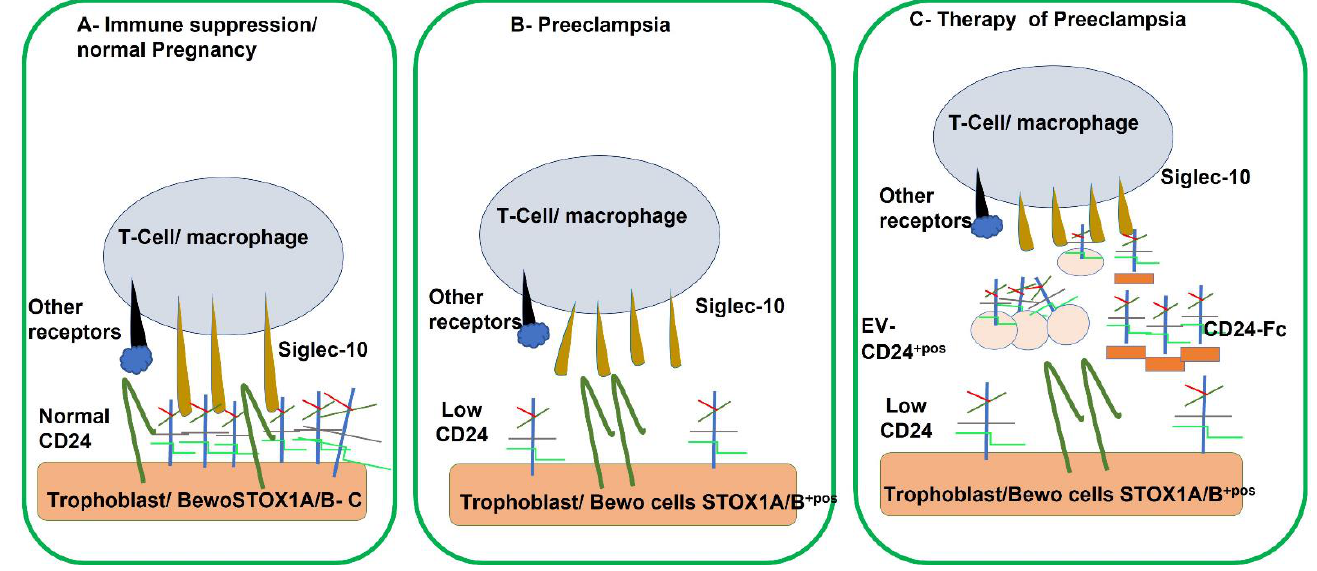
Figure 3. A schematic model of the potential role of CD24 in a normal and in preeclampsia is depicted to indicate how CD24 replenishment could help fighting preeclampsia. ( A ) In normal pregnancy, the immunosuppressive process involves the formation of a complex made of CD24, Siglec-10 and the control STOX1 A/B (STOX1-A/B — C) on the surface of BeWo/trophoblast cells. The complex triggers the inhibitory signals and promotes immunosuppression. ( B ) in preeclampsia there is a reduced amount of CD24-Siglec 10 due to the over expression of the mutated variants of sTOX1 A/B on the surface of the BeWo cells, leading to the loss of immune suppression. ( C ) When replenishment the cultured cells with extracellular vesicles (EV) that have a rich expression of CD24 on their surface, (EV-CD24 +pos ) or with CD24-Fc soluble molecule, the BeWo/trophoblast regain immune tolerance and recover from preeclampsia.